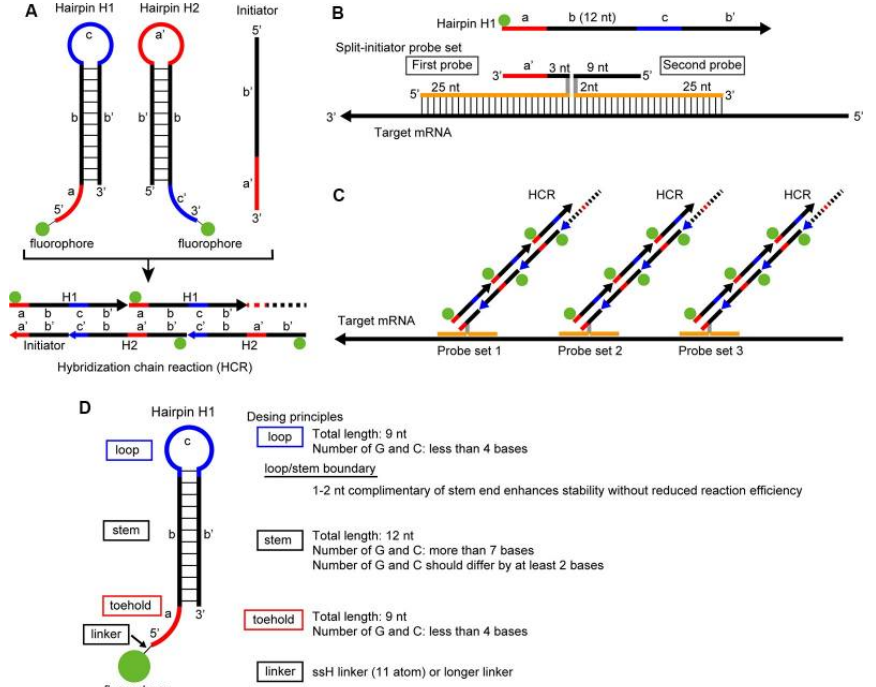
Figure 4. The principles of in situ hybridization chain reaction. ( A ) visualization of hybridization chain reaction (HCR) where metastable fluorescent harpins assemble into amplification polymers for the detection of initiators; the presence of an initiator triggers hybridization chain reaction. H1 complex nucleates with hairpin H2, providing the basis for a chain reaction alternating polymerization steps. ( B , C ) Every HCR protocol consists of two stages: detection and amplification stage. In the detection stage probes are hybridized to the target mRNA sequences and nonhybridized